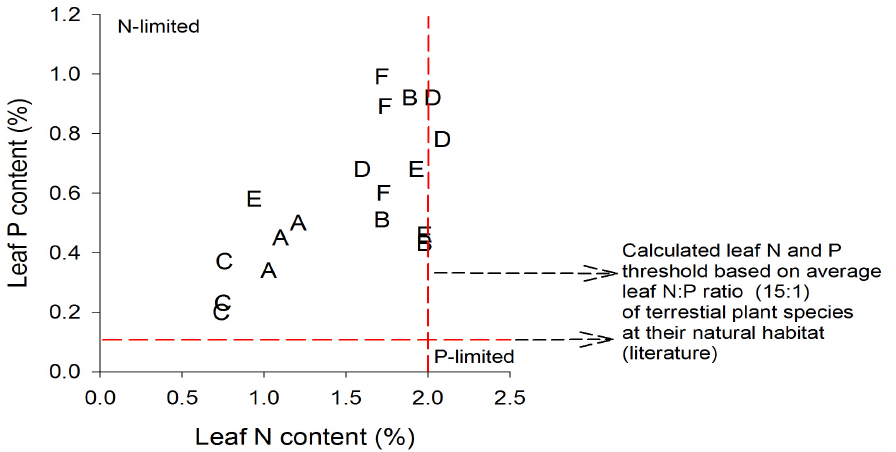
Figure 4. Comparison of the leaf N and leaf P contents of the dominant tree species with the threshold of leaf N and leaf P content calculated based on the suggested leaf N:P ratios by Koerselman and Meuleman (1996) and Aerts and Chapin (1999). Bold letters represent the tree species: (A) Alstonia macrophylla , (B) Buchanania arborescens , (C) Syzygium sp., (D) Casuarina equisetifolia, (E) Acacia mangium, and (F) Terminalia catappa .